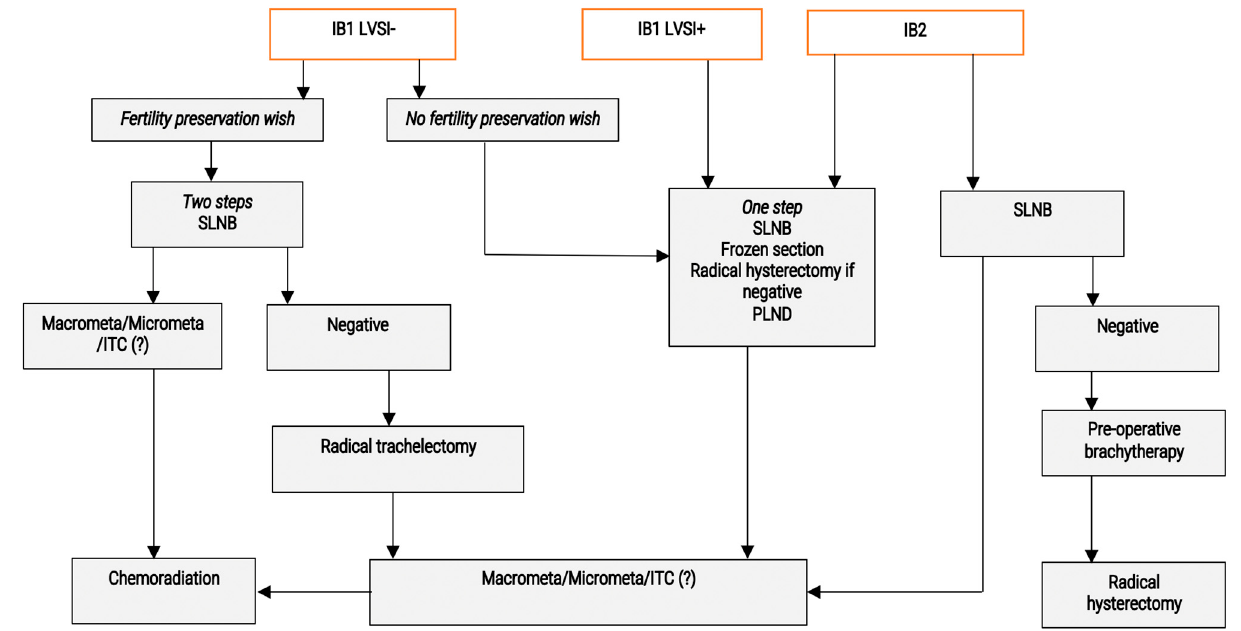
Figure 2. Proposed algorithm for the nodal management of early stage cervical cancer—Stages IB. LVSI: lympho-vascular space invasion; ITC: isolated tumour cells; SLNB: sentinel lymph node biopsy; PLND: para-aortic lymph node dissection.